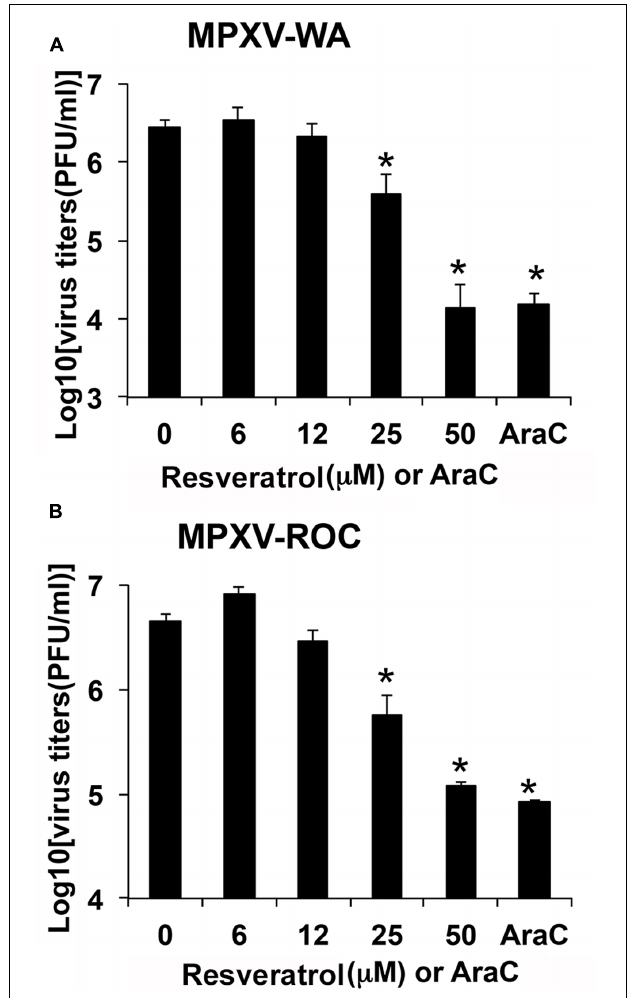
FIGURE 3 | Resveratrol suppresses monkeypox infection. HeLa cells were infected with MPXV-WA (A) or MPXV-ROC (B) at an MOI of 1 in the presence of resveratrol at the indicated concentrations or AraC (40 µ g/mL). Virus yield at 24 hpi was determined by a plaque assay. The asterisk indicates significant difference ( P < 0.05) between DMSO-treated cells and resveratrol- or AraC-treated cells. The error bar indicates standard deviation.